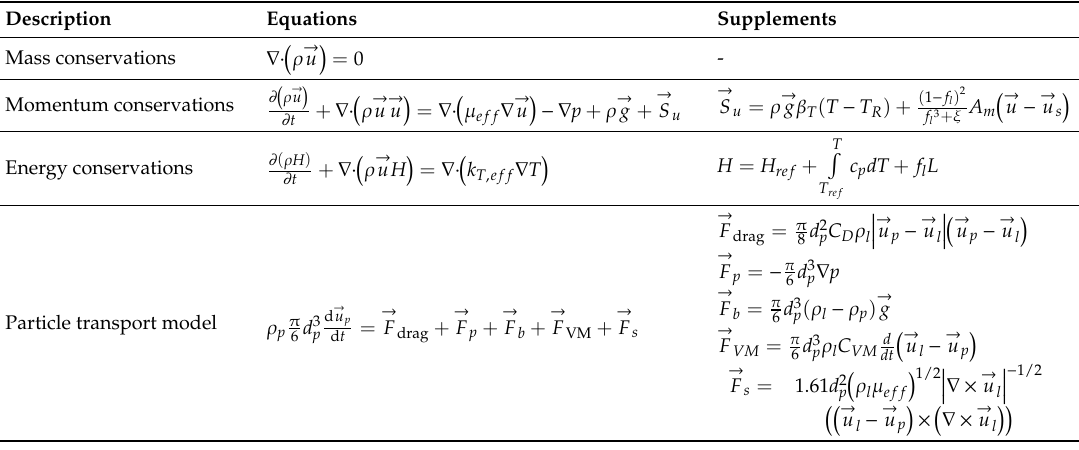
Table 1. Conservation equations for the mathematic